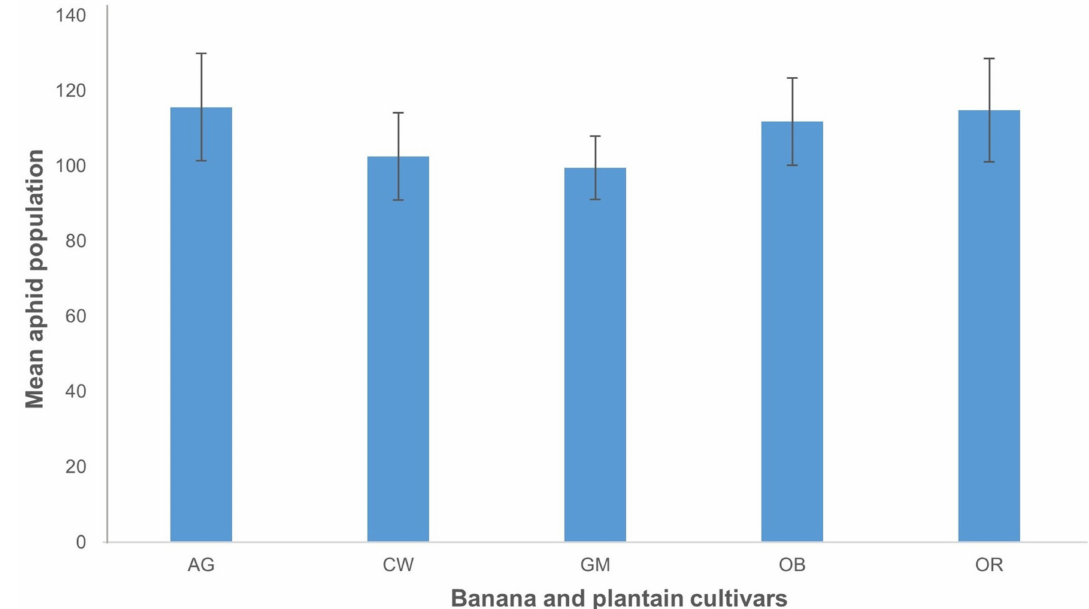
Figure 8. Mean live aphid population growing on nontransgenic plants of various cultivars of banana and plantain. AG—Agbagba, CW—Cavendish Williams, GM—Gonja Manjaya, OB—Obino l’Ewai, and OR—Orishele. Data are presented as means with standard